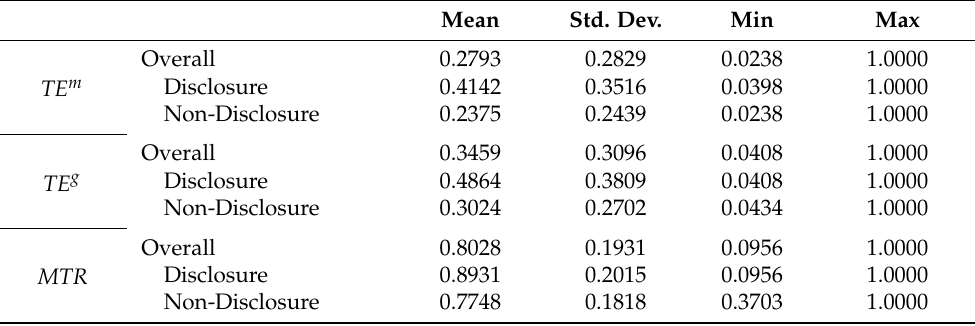
Table 2. Descriptive Statistics of TE m , TE g , and MTR